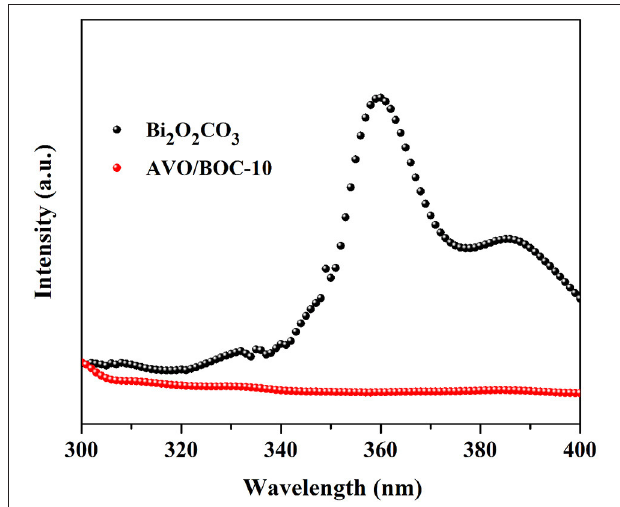
FIGURE 9 | Radical scavenge tests with AVO/BOC-10 as the catalyst.